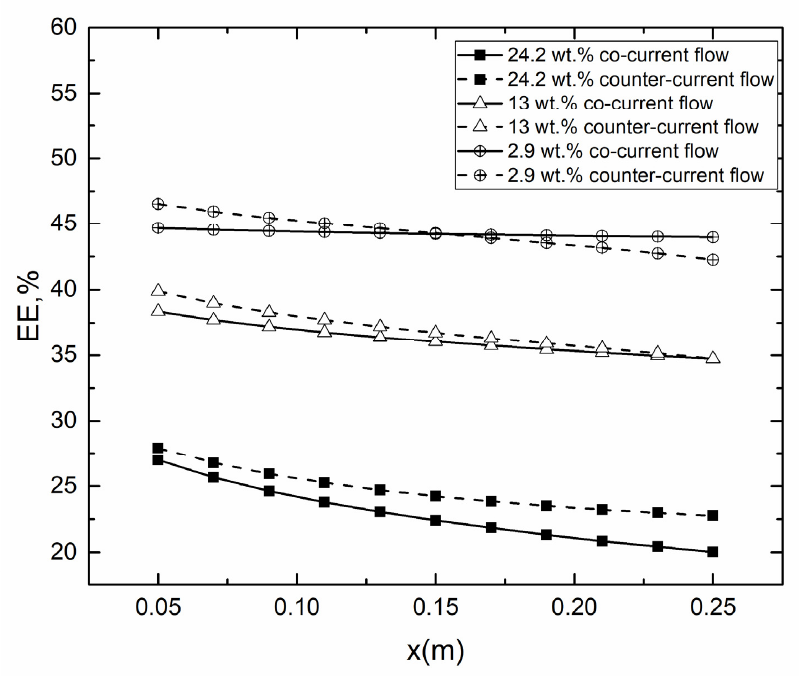
Figure 11. EE for co- and counter-current operations in different c f ( T f = 45 °C, T p = 25 °C, v f , v p = = 0.15 m / 0.15m/s). v p